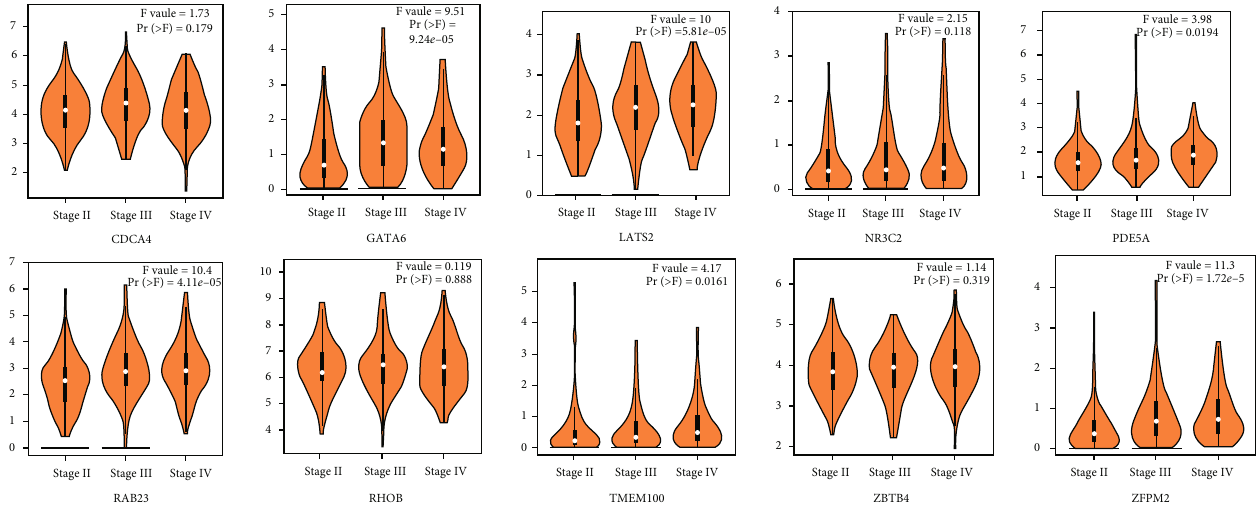
Figure 9: Correlations of top 10 hub genes between expressions and tumor stages. The signi fi cant di ff erence was under the condition of P value <